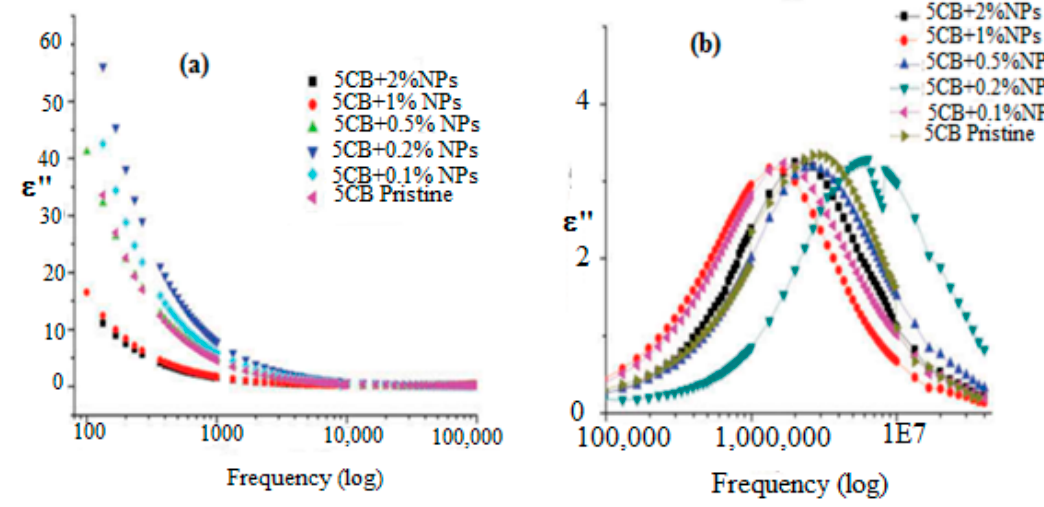
Figure 4. Dielectric losses ε ” as a function of frequency (in Hz) for various concentrations of NPs at